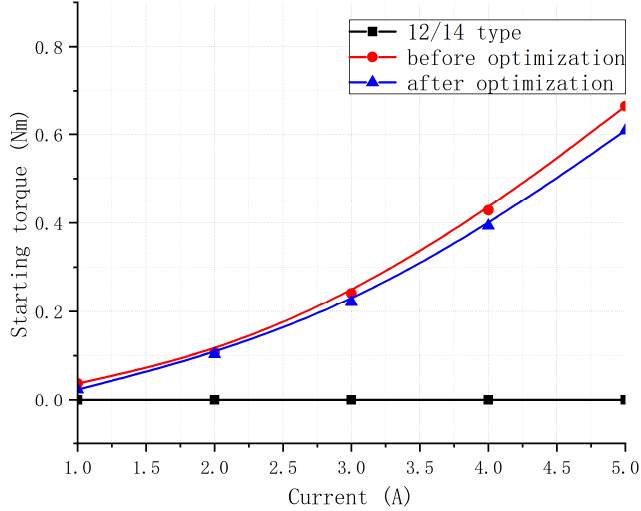
Figure 18. Comparison of starting torques of three motor structures.